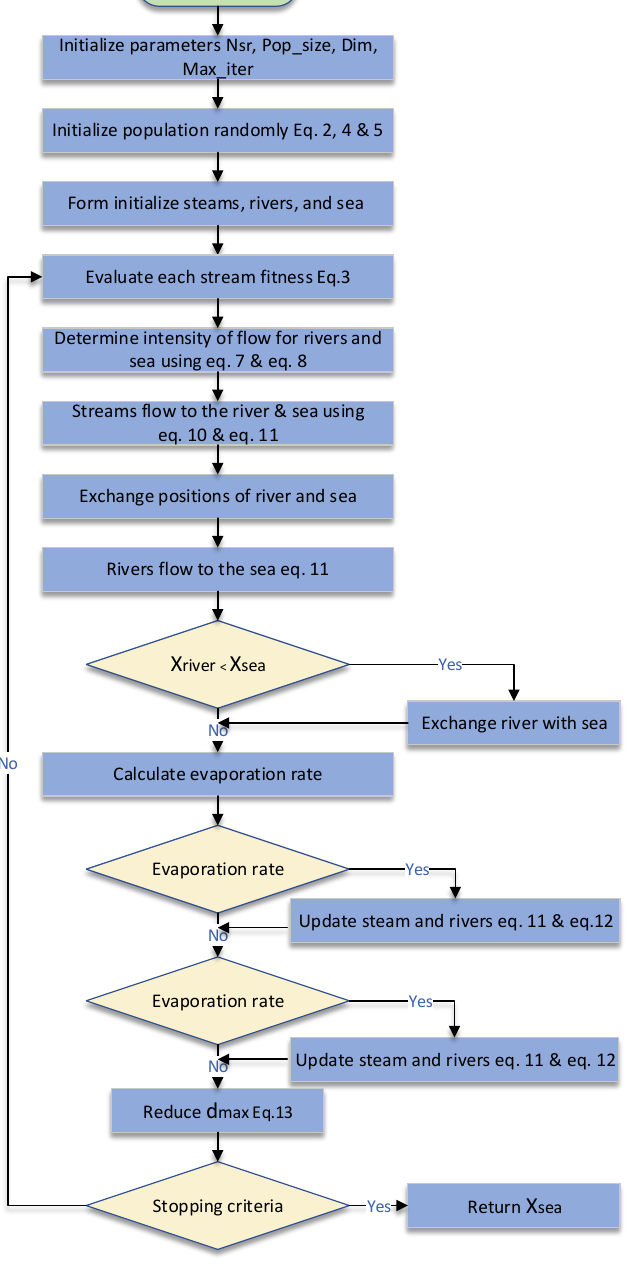
Figure 1. EErWCA flow